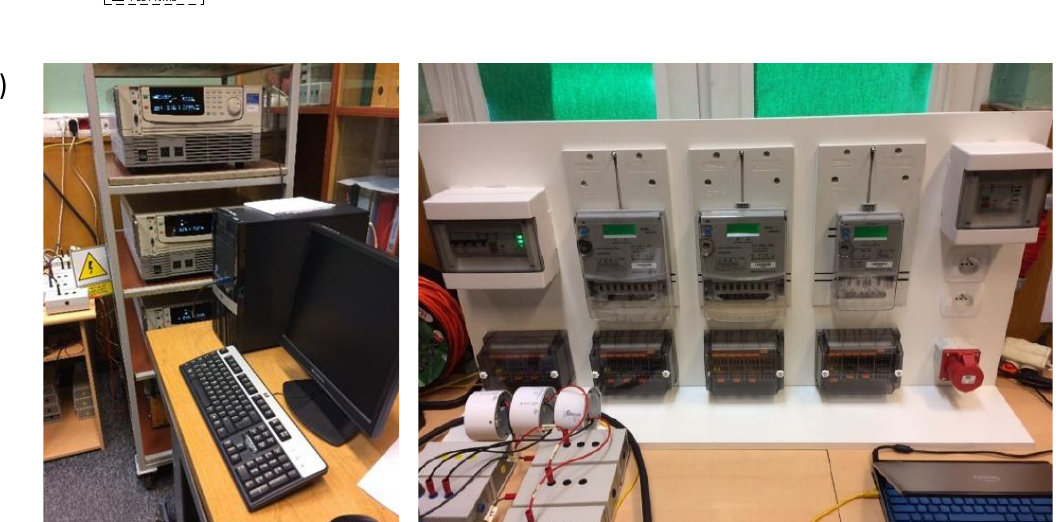
Figure 5. Information and communications technology (ICT) functional diagram of the test stand as a local area network (LAN).